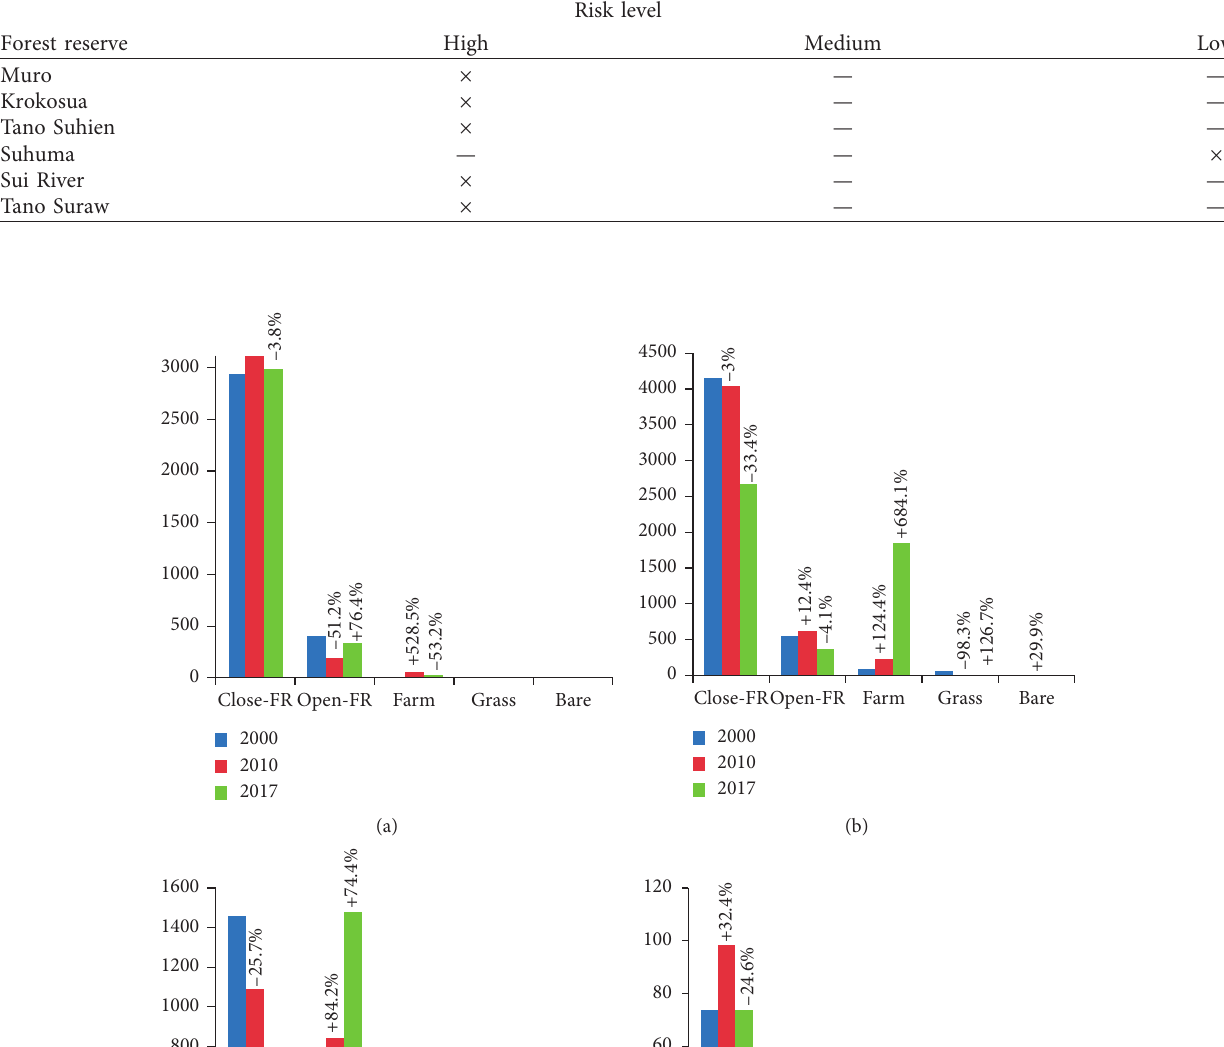
Table 9: Risk Status of the FRs based on road buffer